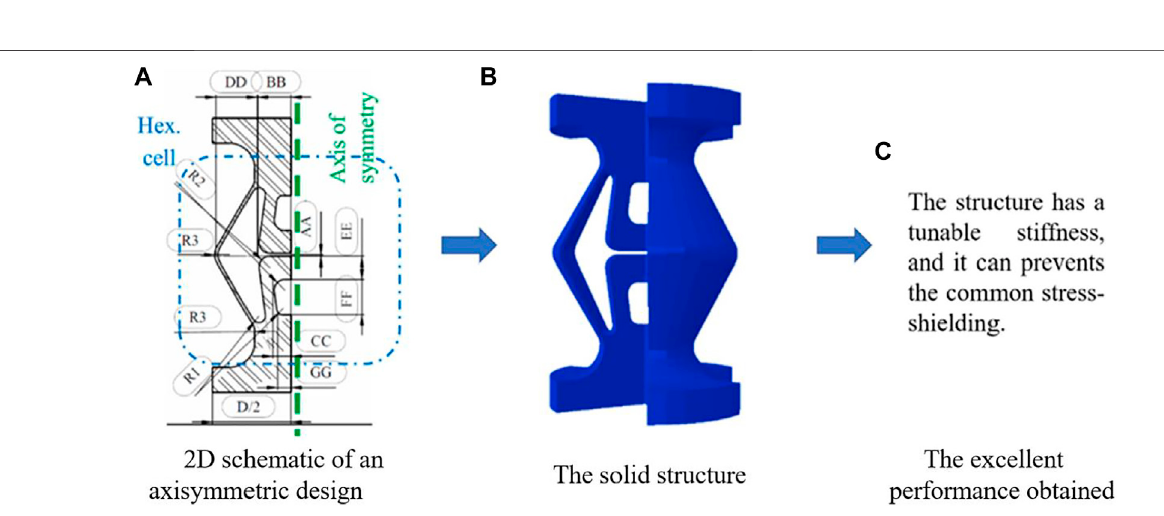
Frontiers in Bioengineering and Biotechnology |